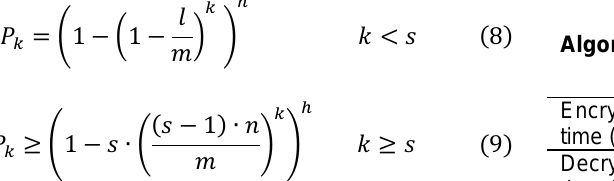
Table 1. Time Consuming of Encrypting and Decrypting a String by Different Algorithms